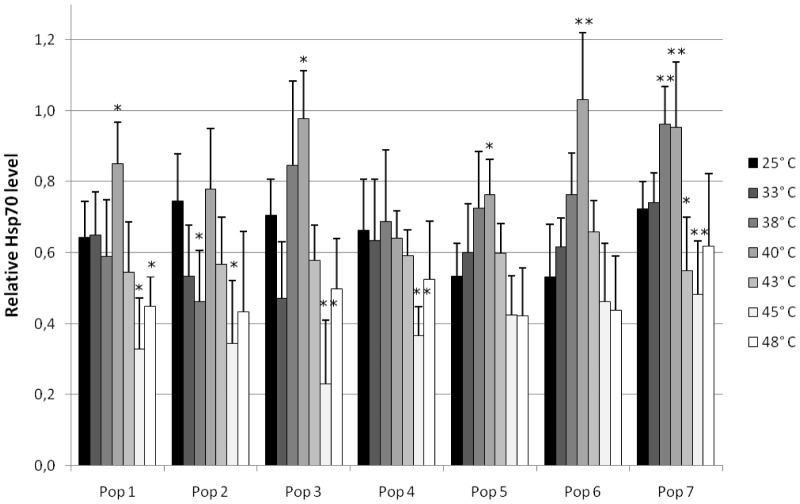
Relative Hsp70 level of different populations after exposure to elevated temperature for 8 h.Shown are means and SD; n = 10. Asterisks show significant differences of the respective exposure groups compared to the control at 25°C after Bonferroni correction: 0.0017<P≤0.0083: (*) and 0.00017<P≤0.0017 (**).